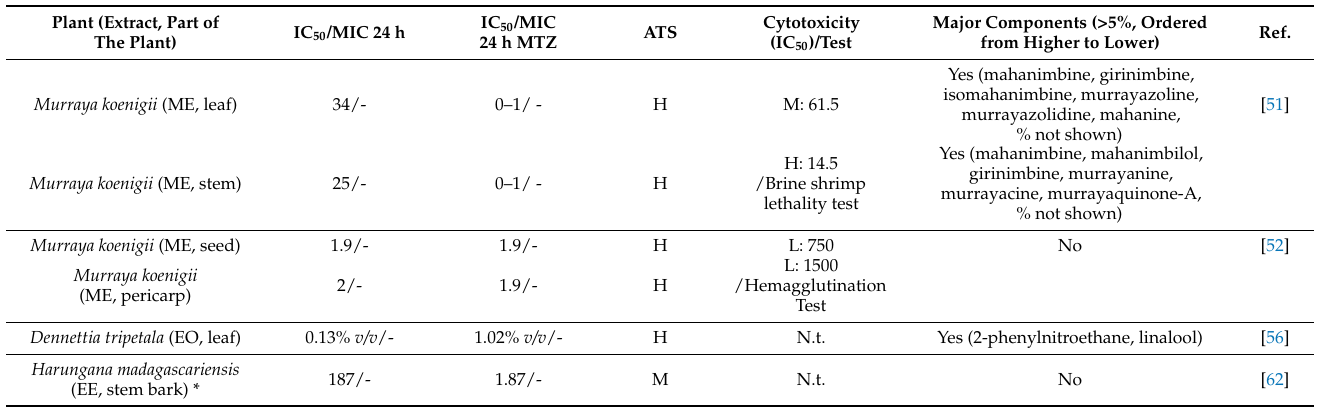
Table 5. Plant extracts employed as anti- T. gallinae in